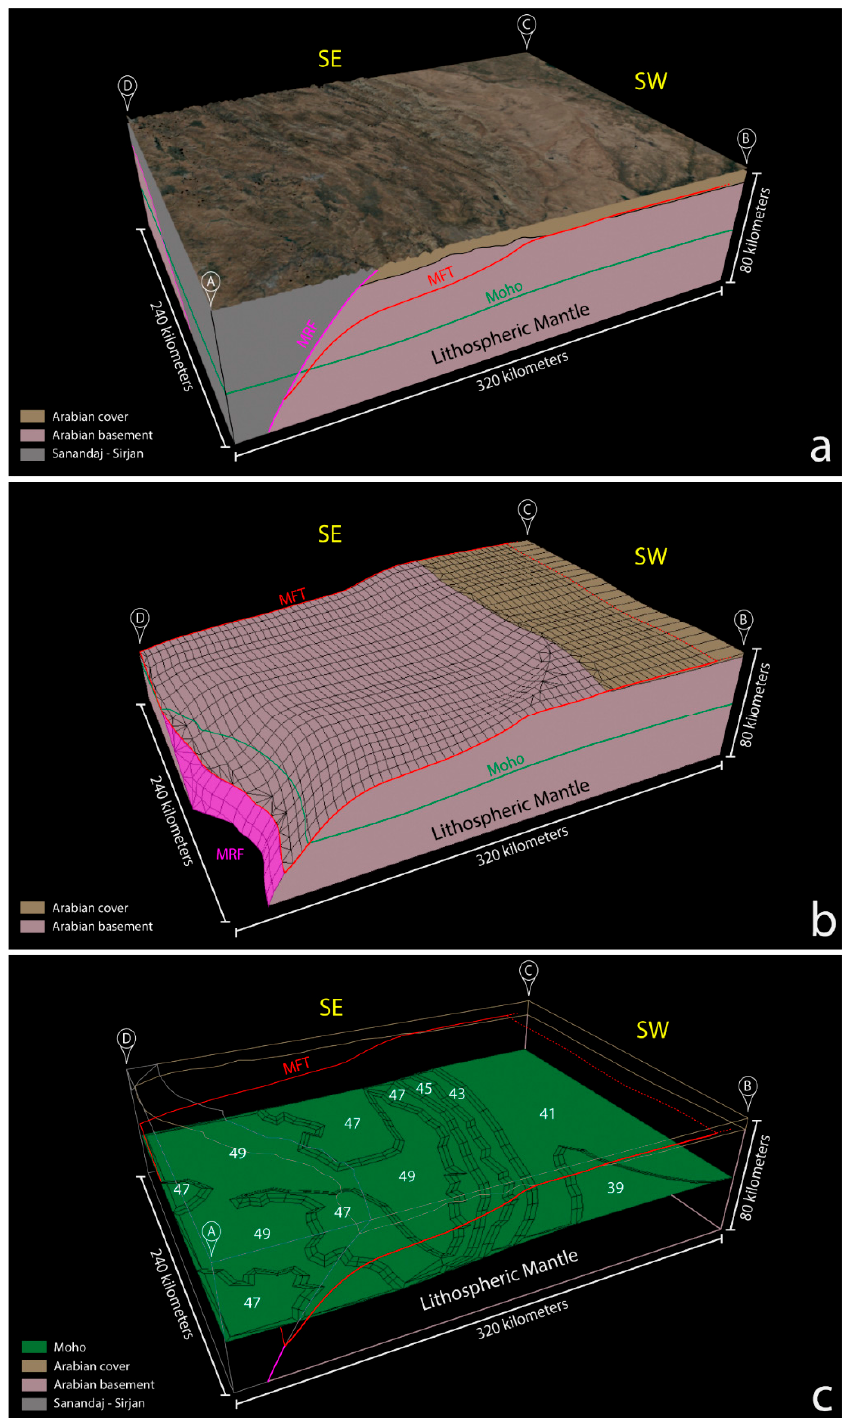
Figure 4. The 3-D geological model. ( a ) Complete 3-D model of 6,144,000 (320 × 240 × 80) km 3 of rock volume, based on geological sections by Basilici et al. [12], Tavani et al. [13], Tavani et al. [14], and Vergès et al. [4]. Topography is from a 30-m resolution ASTER GDEM. The model shows MRF (in purple), MFT (in red), and Moho (in green) in section. ( b ) MFT (red line) footwall topography, including deep sector beneath the branch line with the MRF (in purple). ( c ) Moho contours based on Jiménez-Munt et al. [15], with Moho depth in km (white numbers). In order to provide a better view of MRF and MFT geometry, the lithospheric mantle is not shown as a di ff erent block beneath the Moho